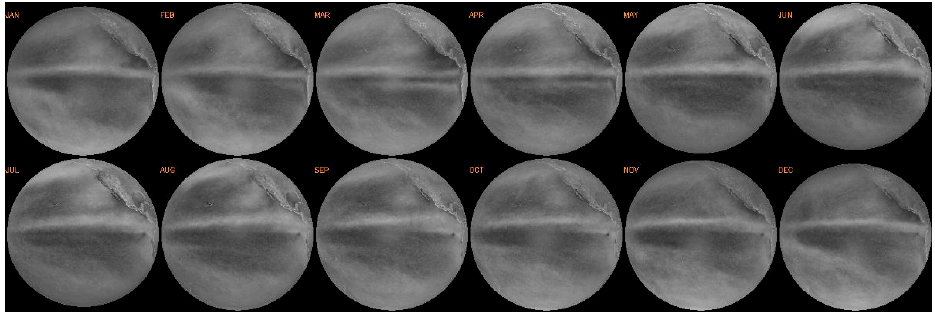
Figure 2. Mean monthly scaled radiance images for GOES-17 (GOES-West) at 21:00 UTC. Data range is from January 2019 through April 2022.